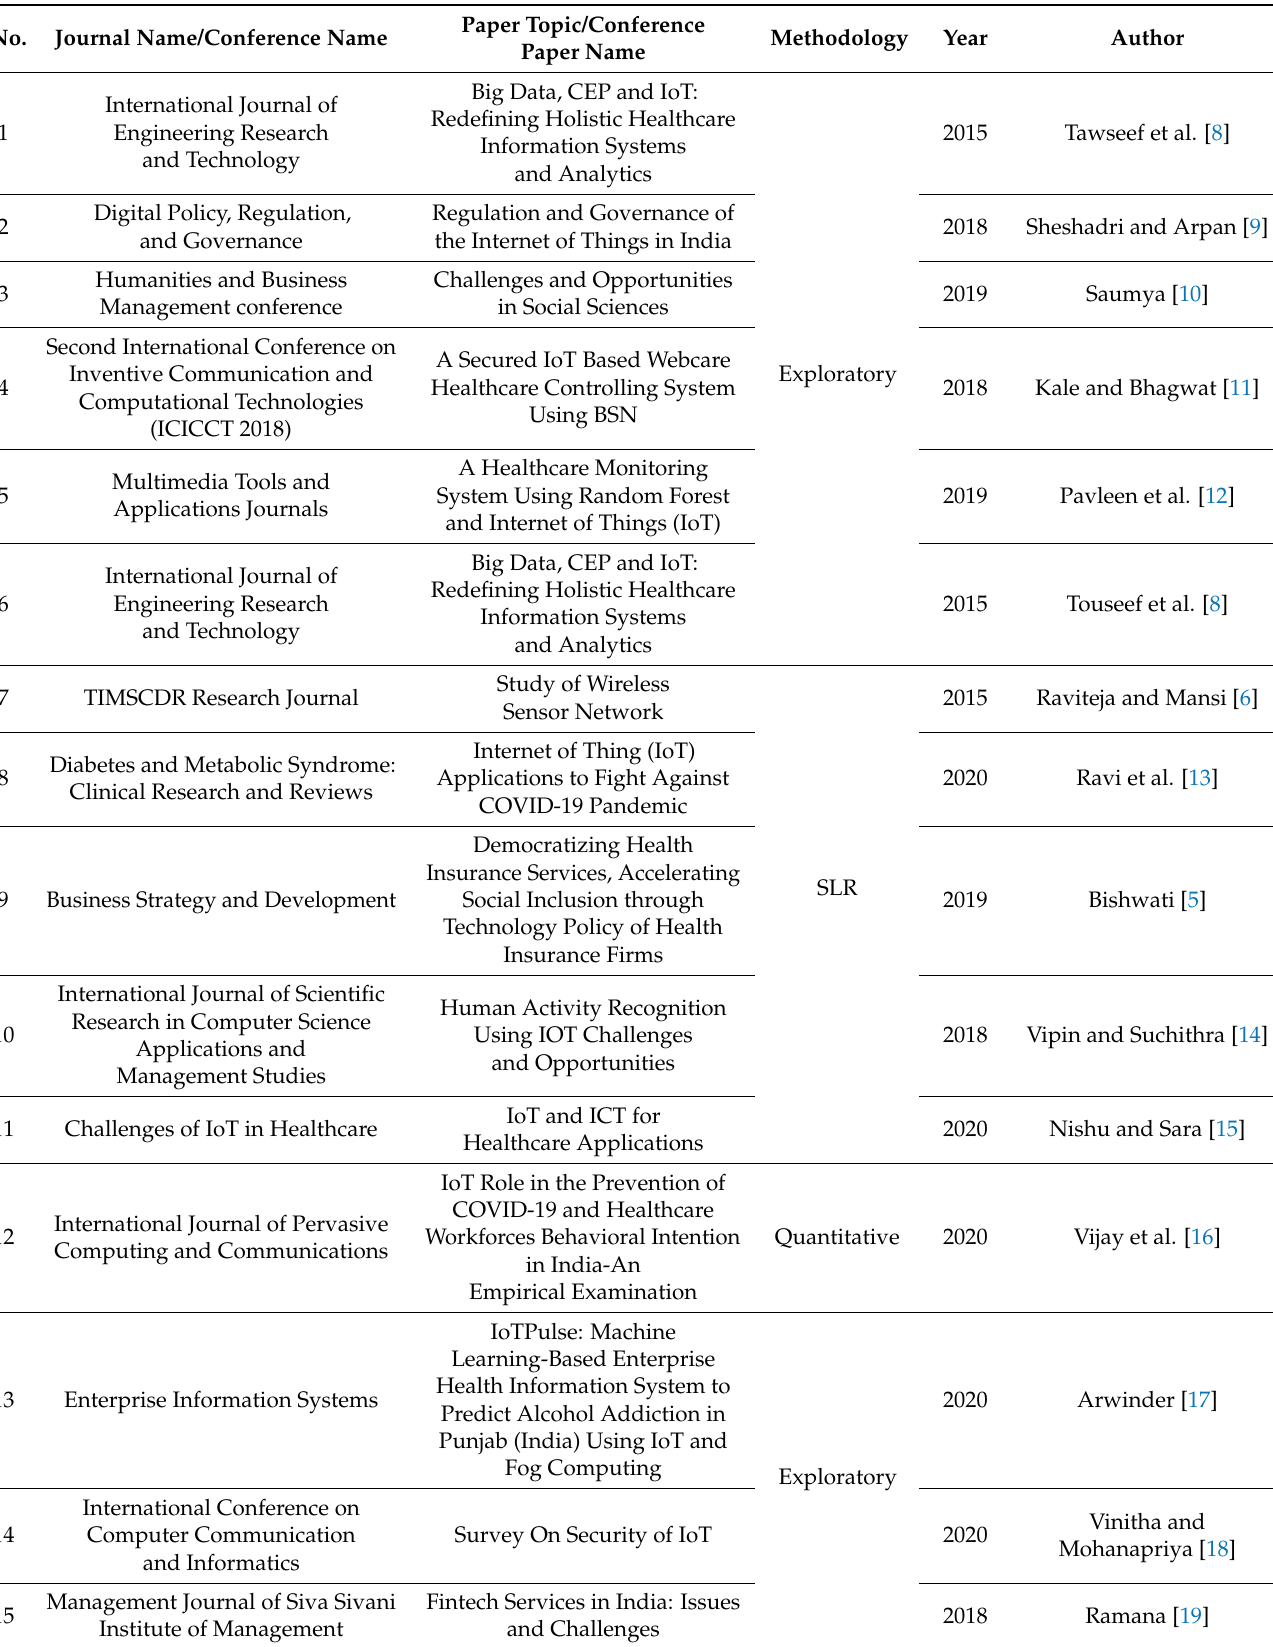
Table 2. Characteristic of reviewed journals of Indian health insurance